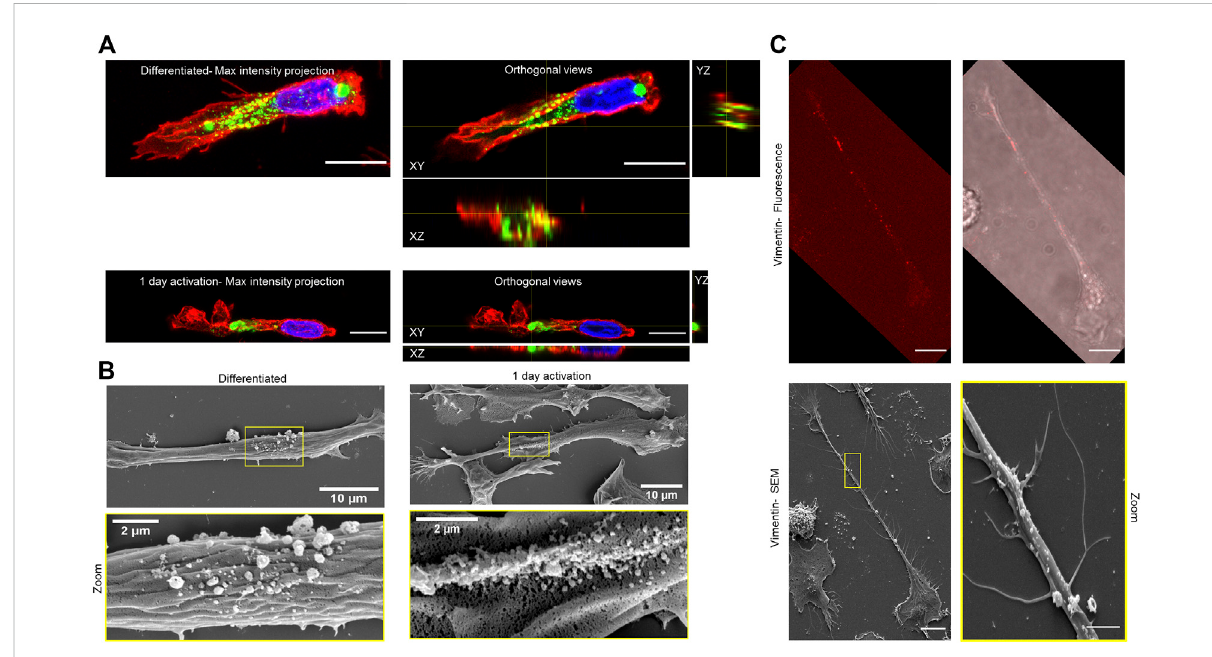
FIGURE 4 Visualisation of surface vimentin on macrophages differentiated from GFP-vimentin HL60. (A) Maximum intensity projection and orthogonal views of differentiated and TNF- α – activated macrophage (red, membrane; green, surface vimentin; blue, nucleus), acquired with confocal microscopy. Scale bar, 10 µm. (B) Scanning electron microscopy images of vimentin secretion sites for the differentiated and TNF- α – activated macrophages. Bottom row: higher magni fi cation of vimentin secretion site marked with yellow rectangle. This study was performed on 2D (glass coverslips) not on fi bronectin coated 1D patterns. In order to have more residual cells after differentiation and activation, we used 1 day activation of both confocal LSM900 (A) and SEM imaging (B) . (C) Confocal and SEM imaging using coverslips with grid. Top: Fluorescence images of vimentin (red; V9 antibody) stained in non-permeablized activated macropahges. Scale bar 10 μ m. Bottom: SEM images of the same cell where the dot like structure can be seen at the same site of vimentin staining. Bottom (Right): magni fi ed image of area marked in yellow of left. Scale bar 2 μ